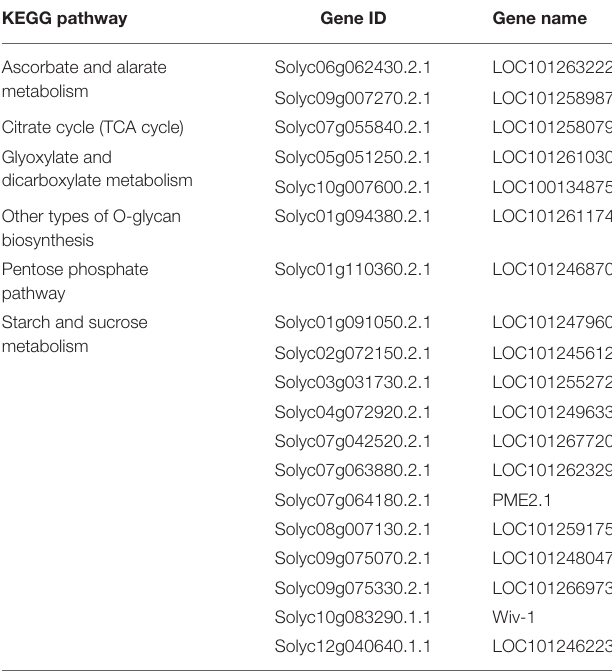
TABLE 7 | Related regulatory genes in carbohydrate metabolic